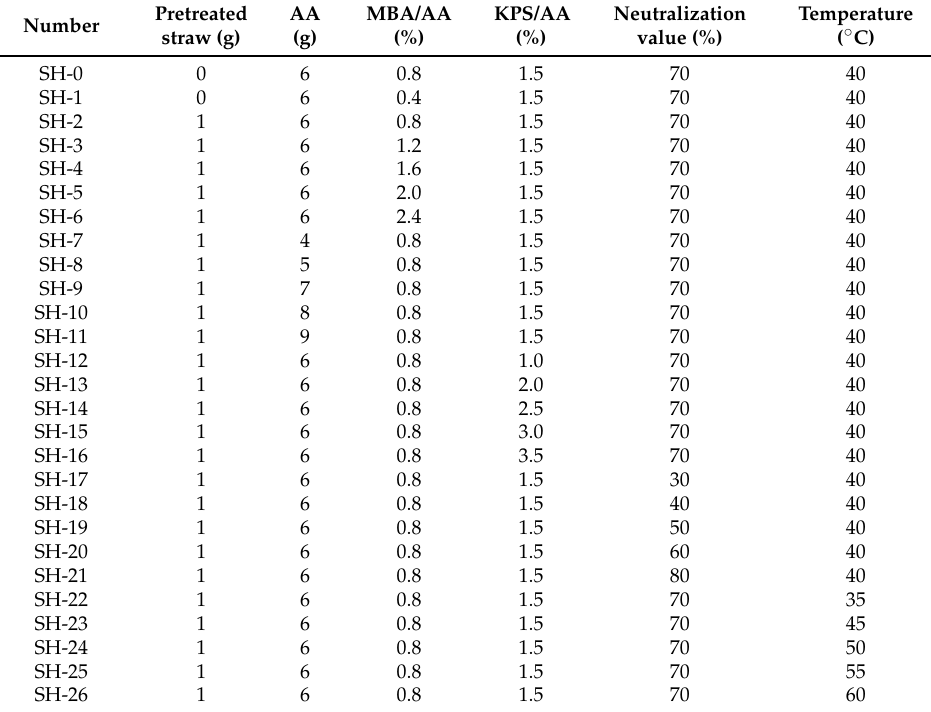
Table 1. Formulations and process parameters of superabsorbent